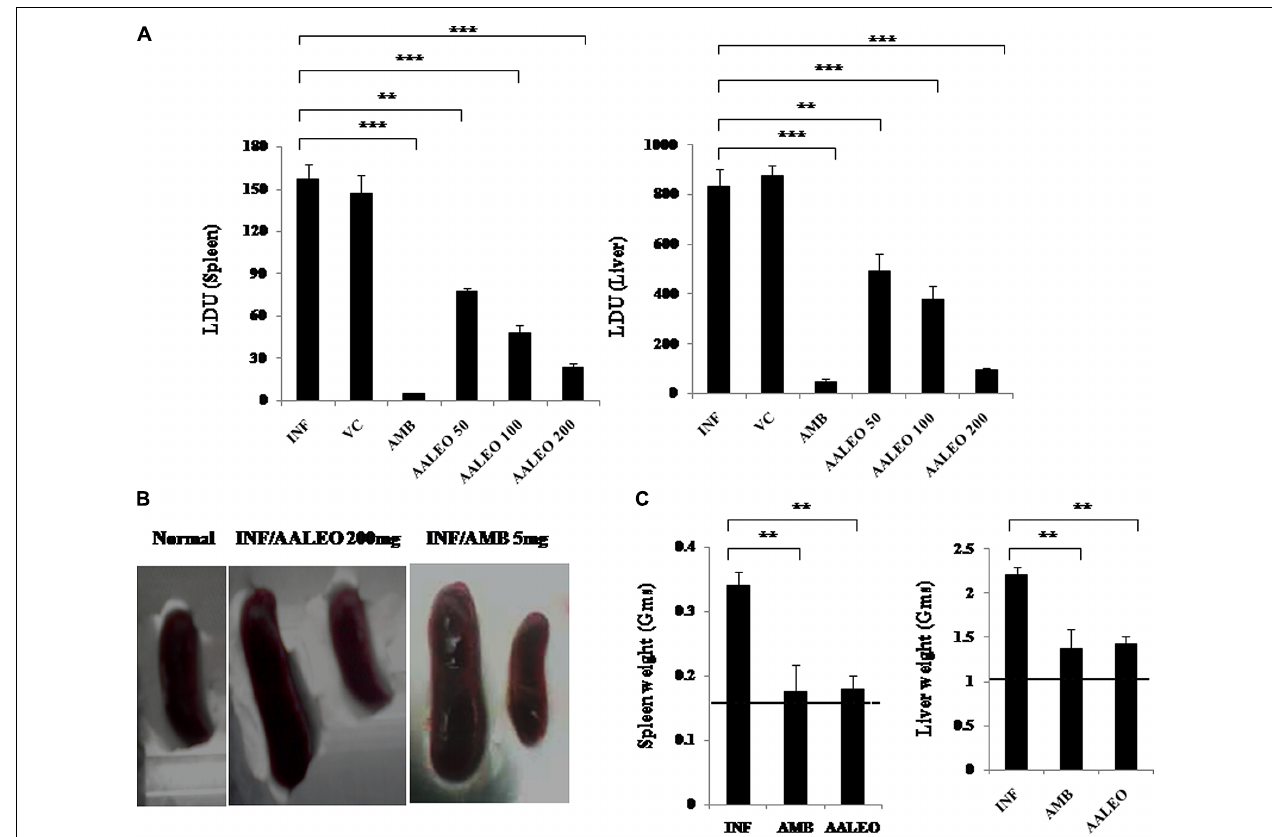
(B) morphology of spleen, and (C) weights of liver and spleen were also determined.The dotted lines indicate the respective organ weights of naïve mice. Data represent the mean ± SE for five animals per group. Data were tested by ANOVA. Differences between means were assessed for statistical significance byTukey’s test (** P ≤ 0.01; *** P ≤ 0.001). Results are from one of three representative